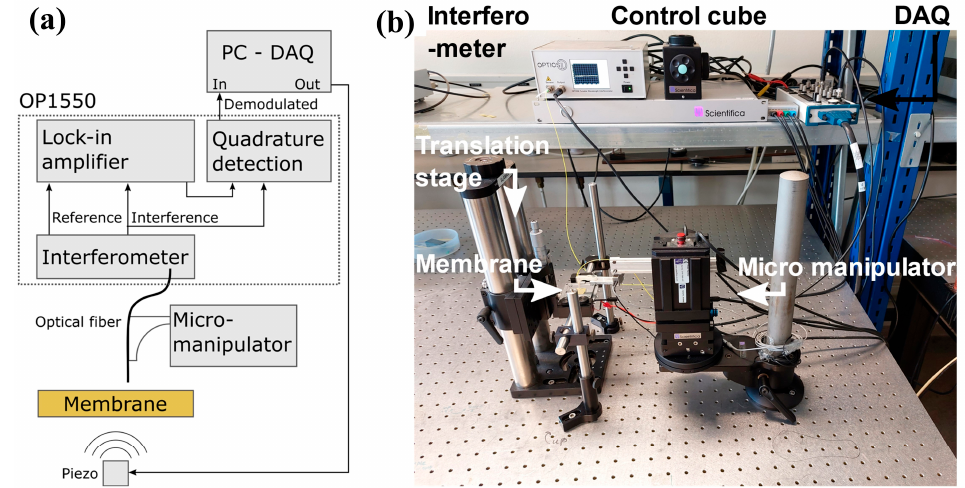
Figure 2. ( a ) Schematic of the setup and ( b ) a photograph of the setup. The piezo is positioned within a distance of approximately 8 mm from the membrane with the translation stage. A controller cube is used to control the micromanipulator and move the fiber close to the center of the membrane. The DAQ generates a sine wave that drives the piezo element for a specific duration and at a specific frequency and amplitude.